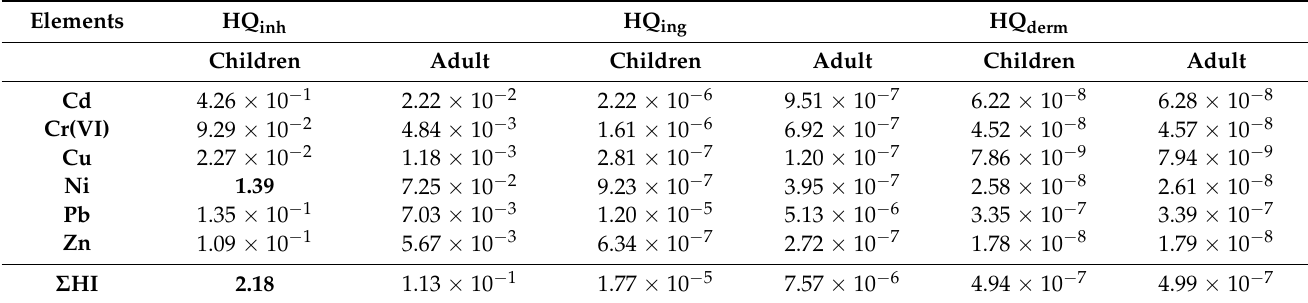
Table 1. Non-carcinogenic trace elements’ health risk through inhalation (HQ inh ), ingestion (HQ ing ) and dermal exposure (HQ derm ), and the hazard index (HI) for both children and adults.